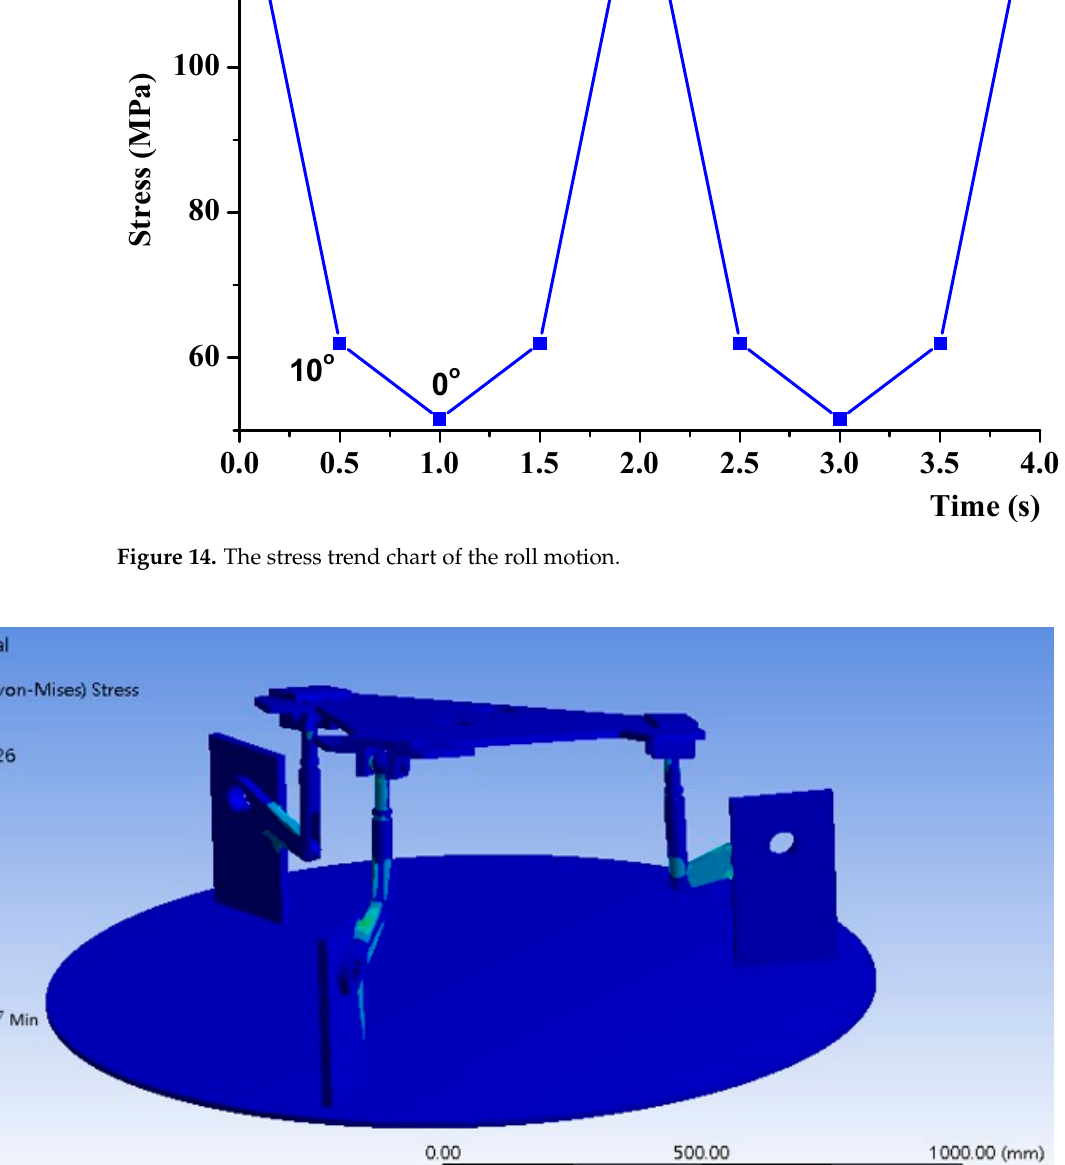
Figure 15. The maximum stress of the pitch motion.